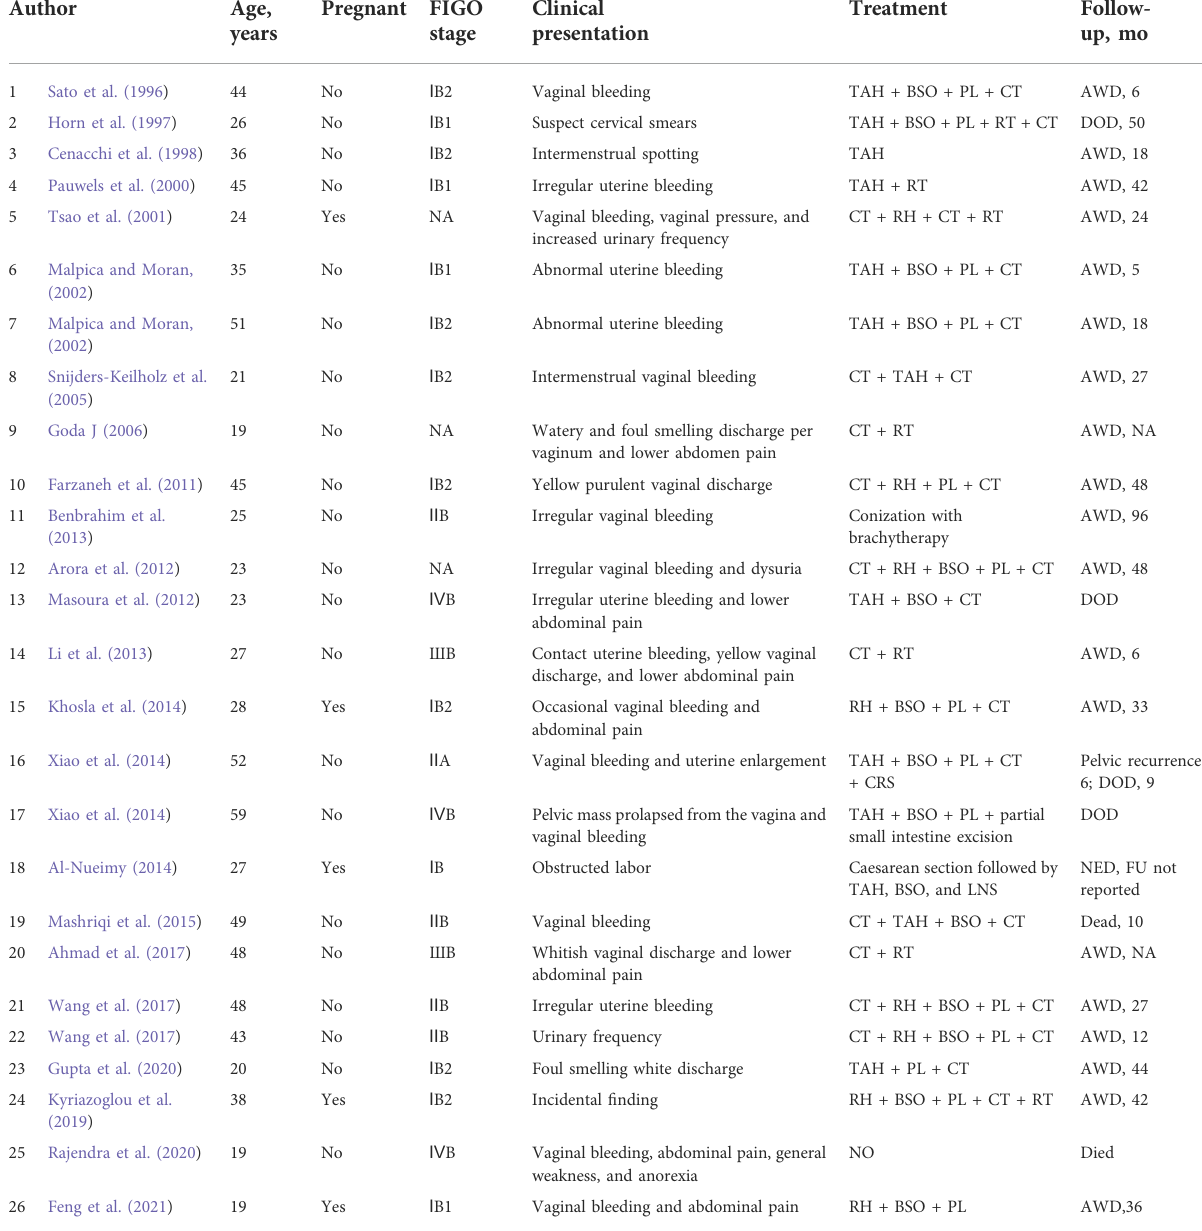
TABLE 1 Summary of clinical presentation, management, and outcome of PNET of the uterine